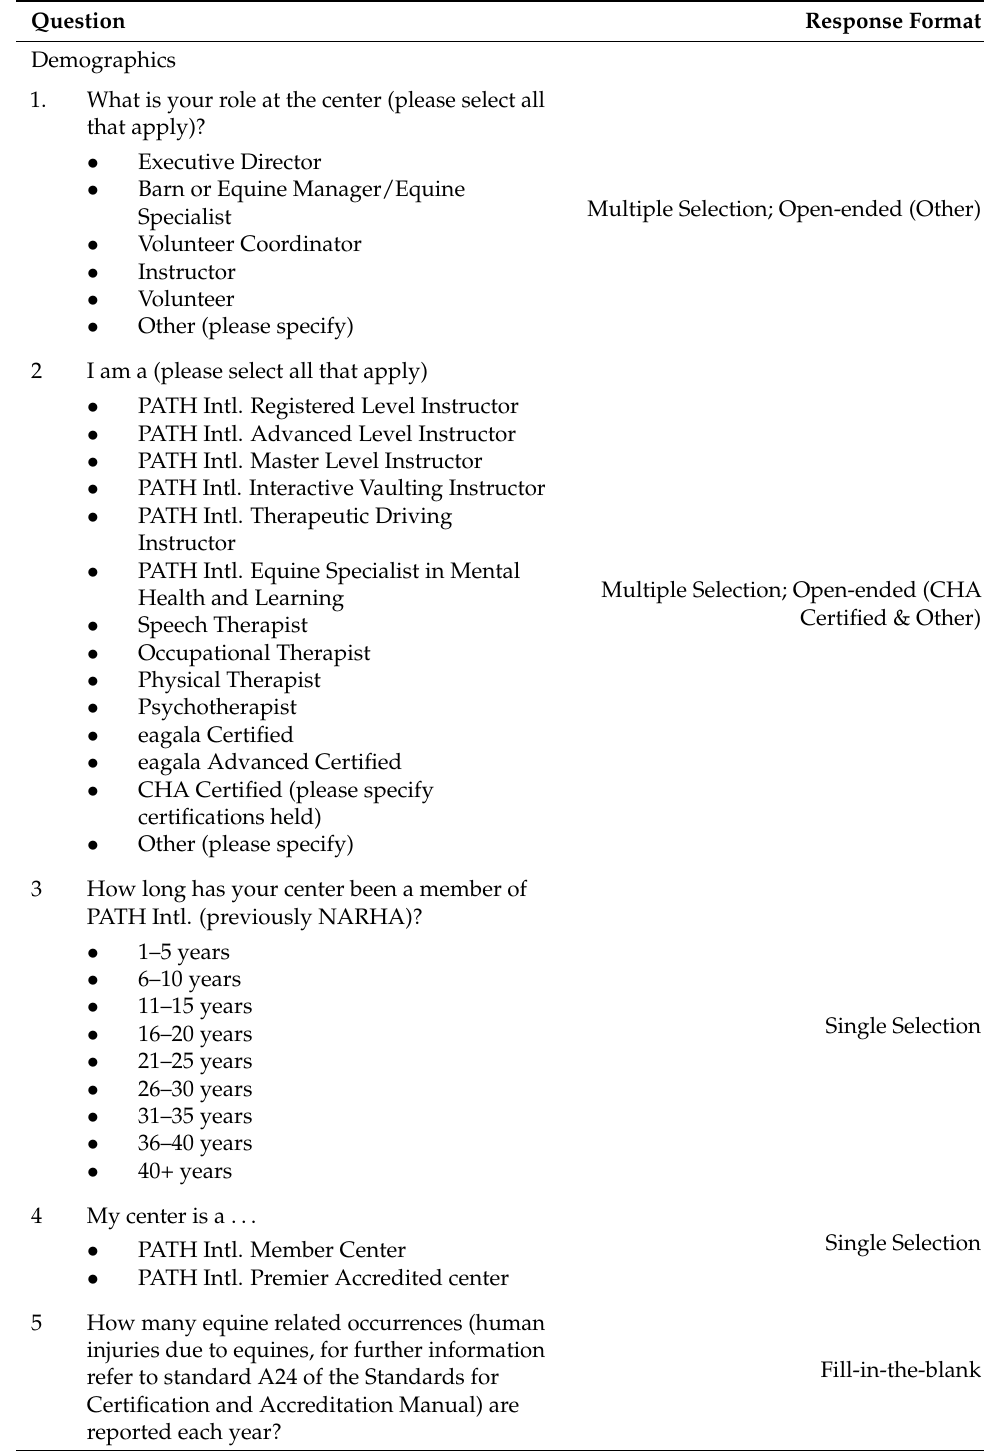
Table A1. Survey questions used in part I of the